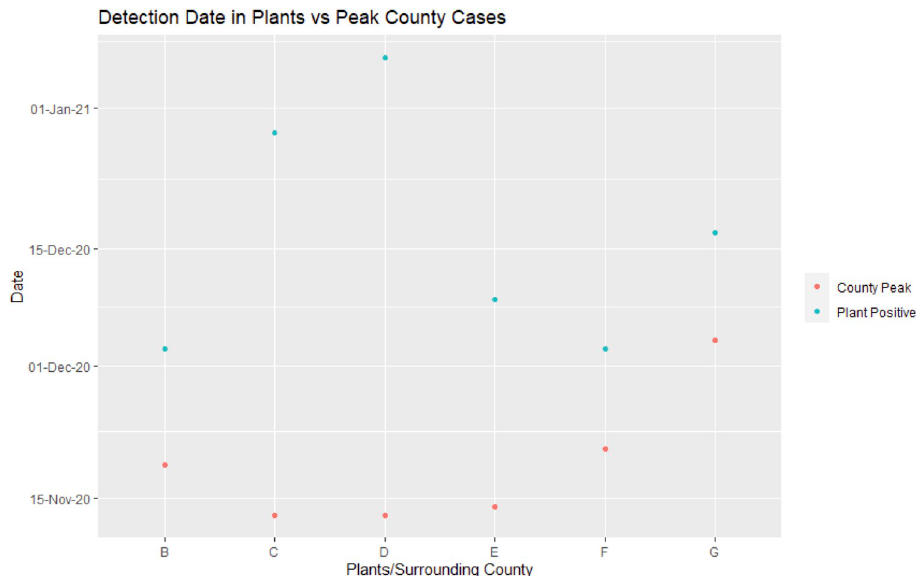
Fig 1. SARS-CoV-2 detection in plants vs peak county cases. Each letter on the x-axis represents a meatpacking plant and its surrounding county. Plotted on the y-axis are the dates that each county peaked with SARS-CoV-2 positive tests and the date that SARS-CoV-2 was detected in each plant by our surveillance [15–18].